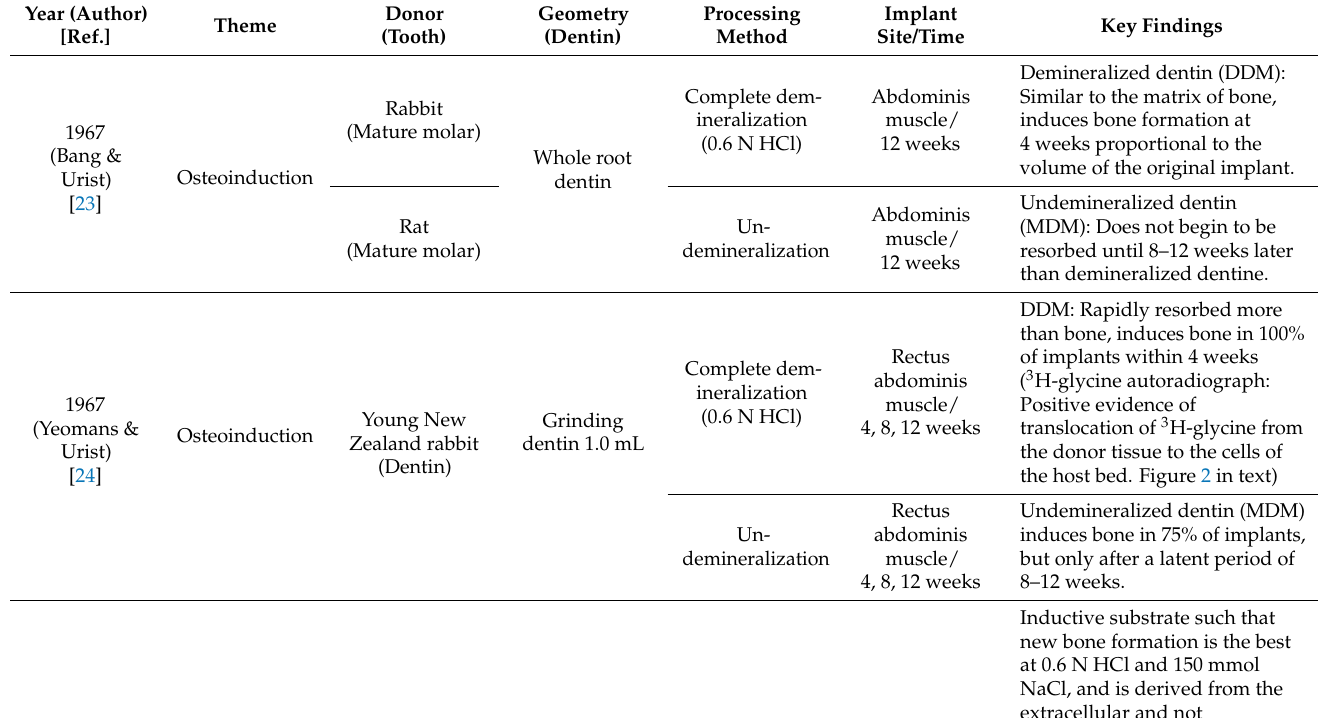
Table 1. Summary of preclinical evidence on bone induction capacity of allogeneic dentin at extraskeletal